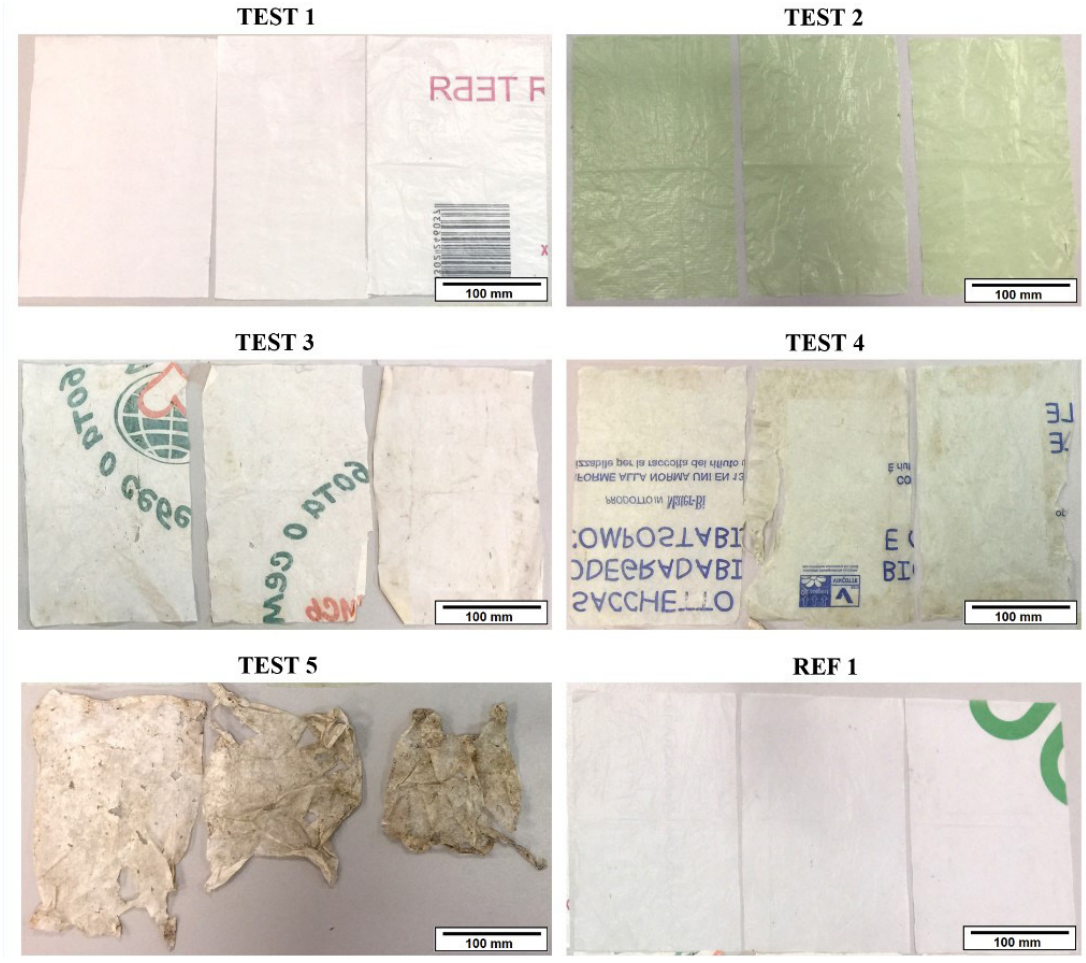
Figure 2. The samples after 3 months of the open-air soil test